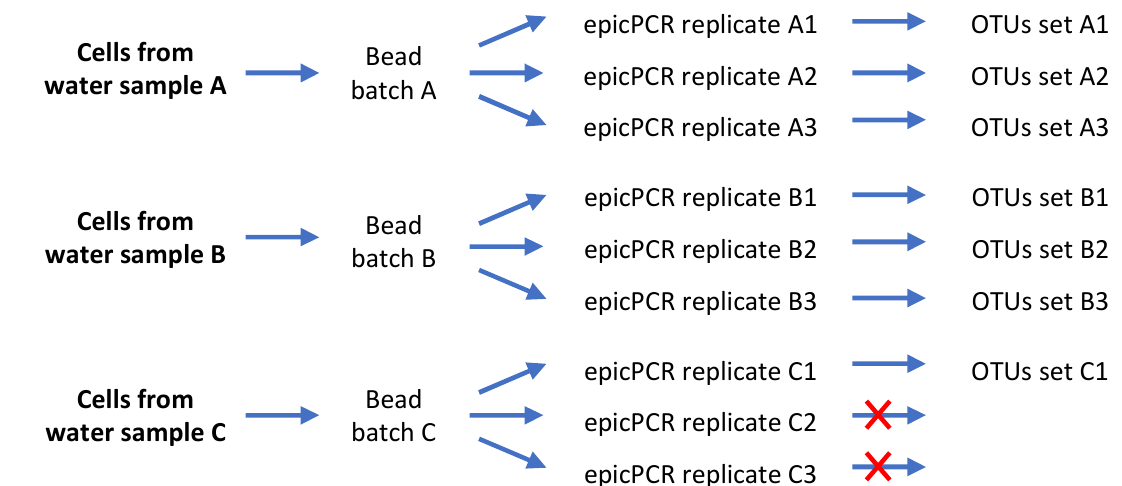
Figure 4. Replicate strategies for taxonomic assignment of SXT/R391 elements in the Meurthe River water by epicPCR. Each bead batch allowed performing the original epicPCR approach using a set of technical replicates that can be considered and analyzed as either triplicates (1 combination) or duplicates (3 combinations if ignoring one of the repeats without statistical a priori). The use of biological replicates implies using OTUs obtained from different bead batches. By doing so, 15 biological duplicates (3 × 3 + 3 × 1 + 3 × 1 = 15 combinations) or 9 biological triplicates (3 × 3 × 1 = 9 combinations) can be considered. Red crosses indicate epicPCR amplifications for which the sequencing of the resulting amplicons did not reach the minimal quality requirement.